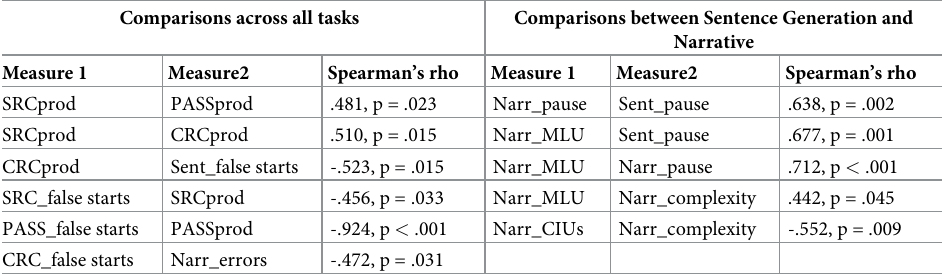
Table 6. Results for the correlational analysis of comparable parameters across language